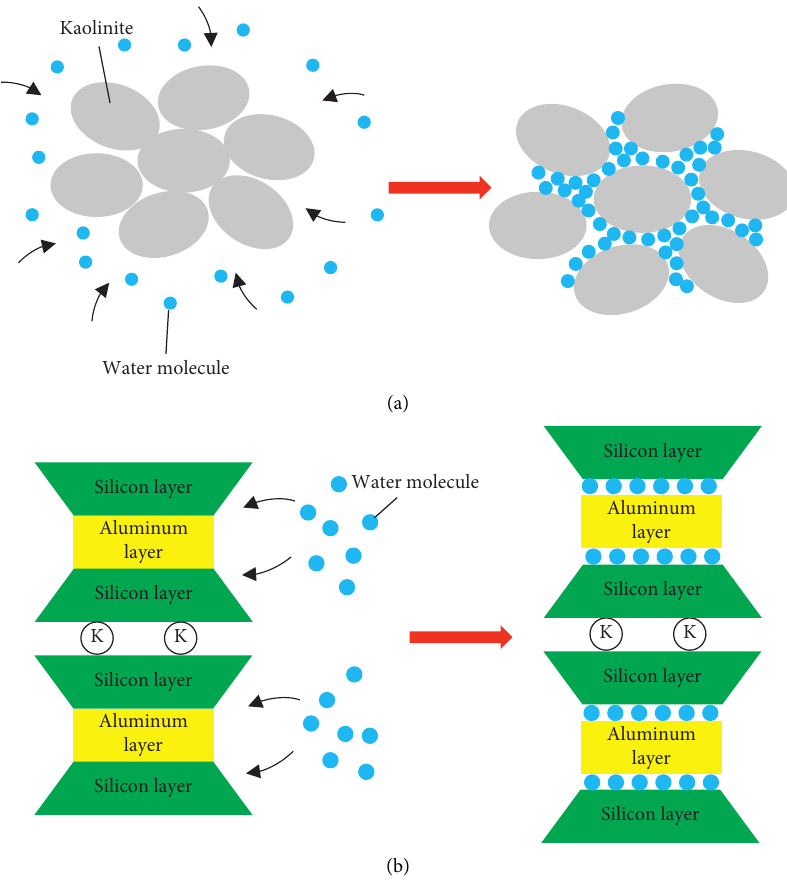
Figure 10: Swell mechanism of the soft rock: (a) cementing expansion; (b) internal